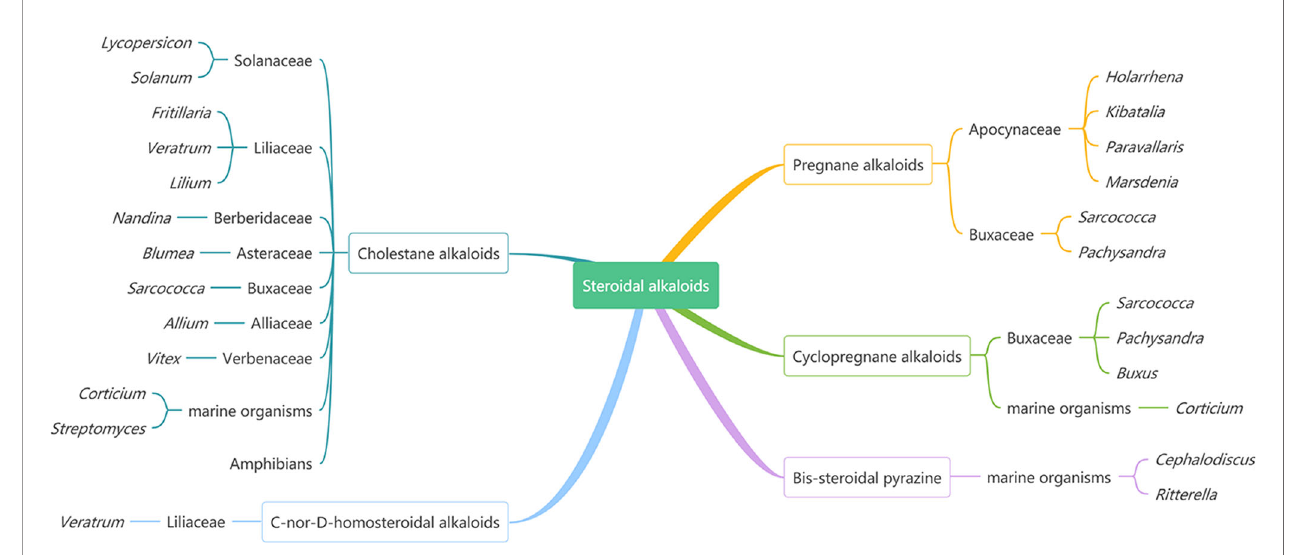
FIGURE 1 | The Main Sources of Steroidal